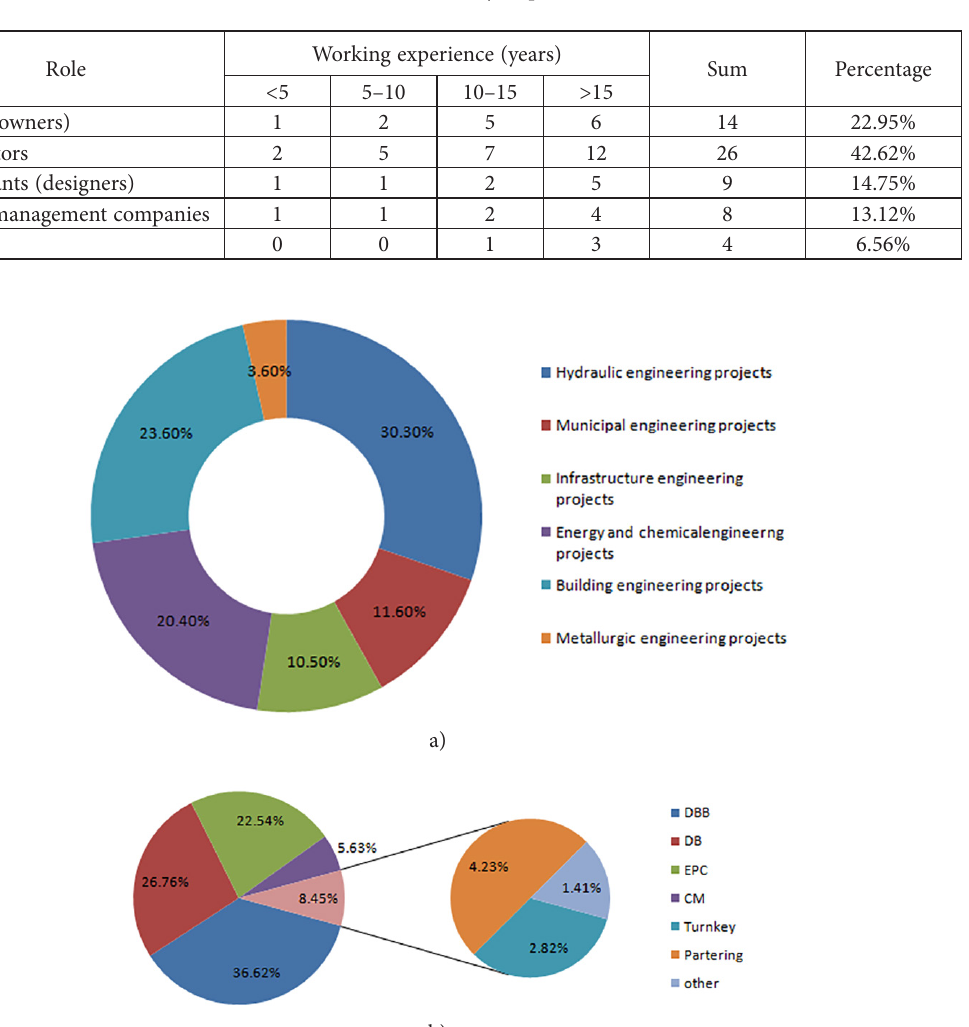
Figure 1. Sample composition: a) distribution of respondent project types